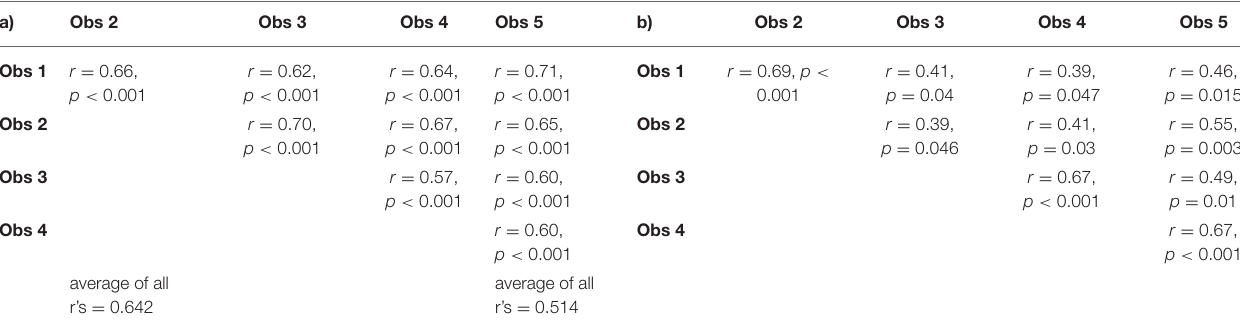
TABLE 1 | Spearman’s rank correlation coefficients (r) for the inter-observer